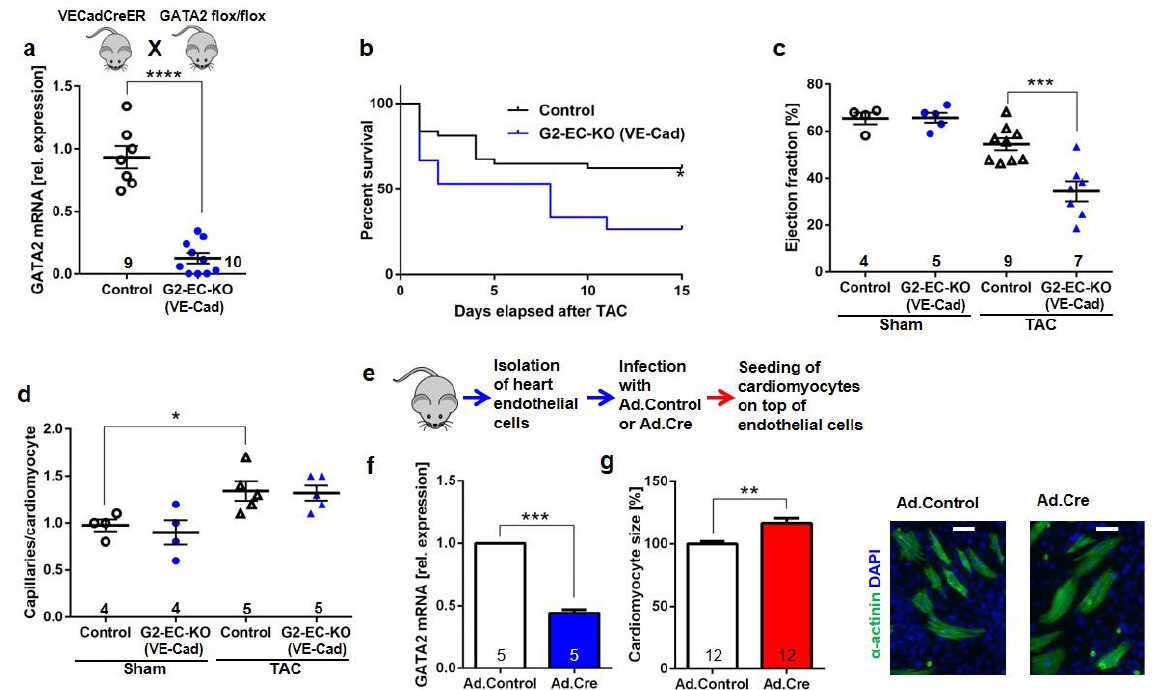
Figure 3. Endothelial GATA2 knock-out mice (VE-Cad-Cre-G2-EC-KO) develop heart failure and increased mortality during pressure overload (TAC). ( a ) qPCR of GATA2 mRNA in cardiac endothelial cells (EC) from indicated mice. ( b ) Kaplan – Meier survival curves after TAC ( n = 37 control and n = 16 VE-Cad-G2-EC-KO) ( c ) EF of mice 4 weeks after TAC. ( d ) Capillaries/cardiomyocyte ratio. ( e ) Scheme of the experiment shown in ( f ), and ( f ) qPCR analysis of GATA2 mRNA in juvenile GATA2flox/flox ECs treated as indicated. ( g ) Quantification of the cell size of cardiomyocytes (CMs) grown on the top of ECs treated as shown. Representative immunofluorescence pictures stained as indicated (scale bar, 50 µm). Data are mean ± sem; the number of biological replicates is shown in the graphs; * p < 0.05, ** p < 0.01, *** p < 0.001, **** p < 0.0001.